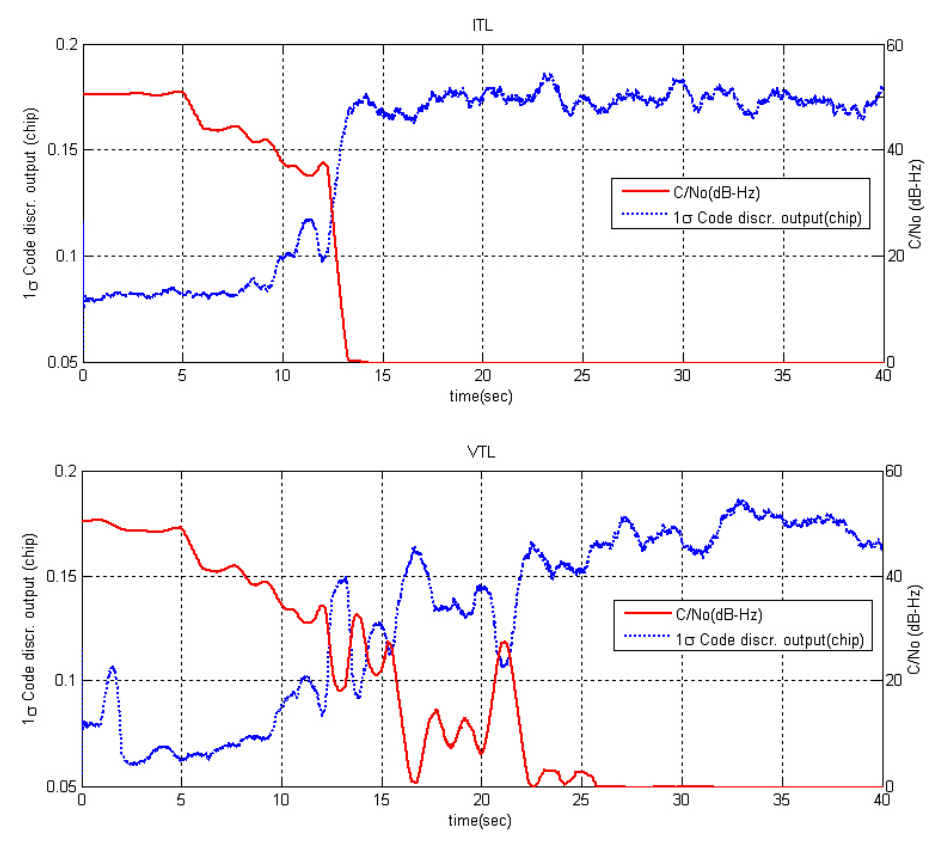
Figure 23. Tracking Results of PRN 4: ITL (top) and VTL